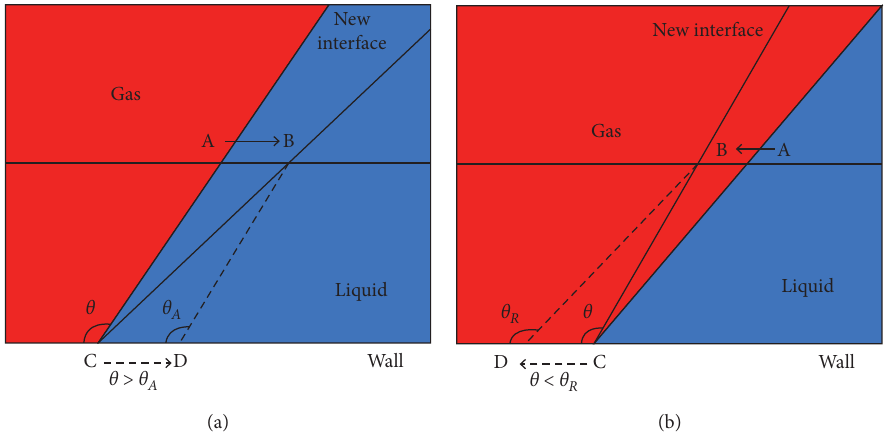
Figure 1: Illustration of dynamic contact angle model: (a) advancing contact angle; (b) receding contact angle.